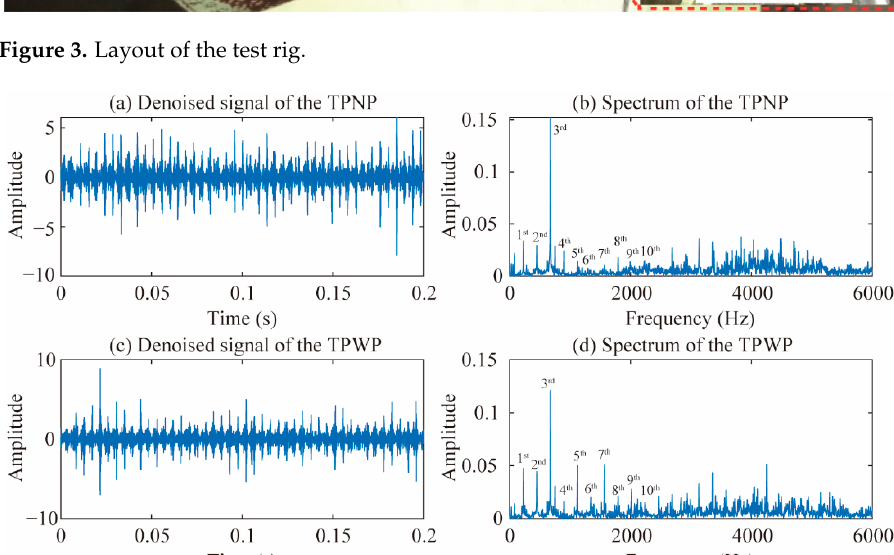
Figure 4. Denoised signals and the FT spectra. ( a ) Denoised signal of the TPNP; ( b ) spectrum of the TPNP; ( c ) denoised signal of the TPWP; ( d ) spectrum of the TPWP.